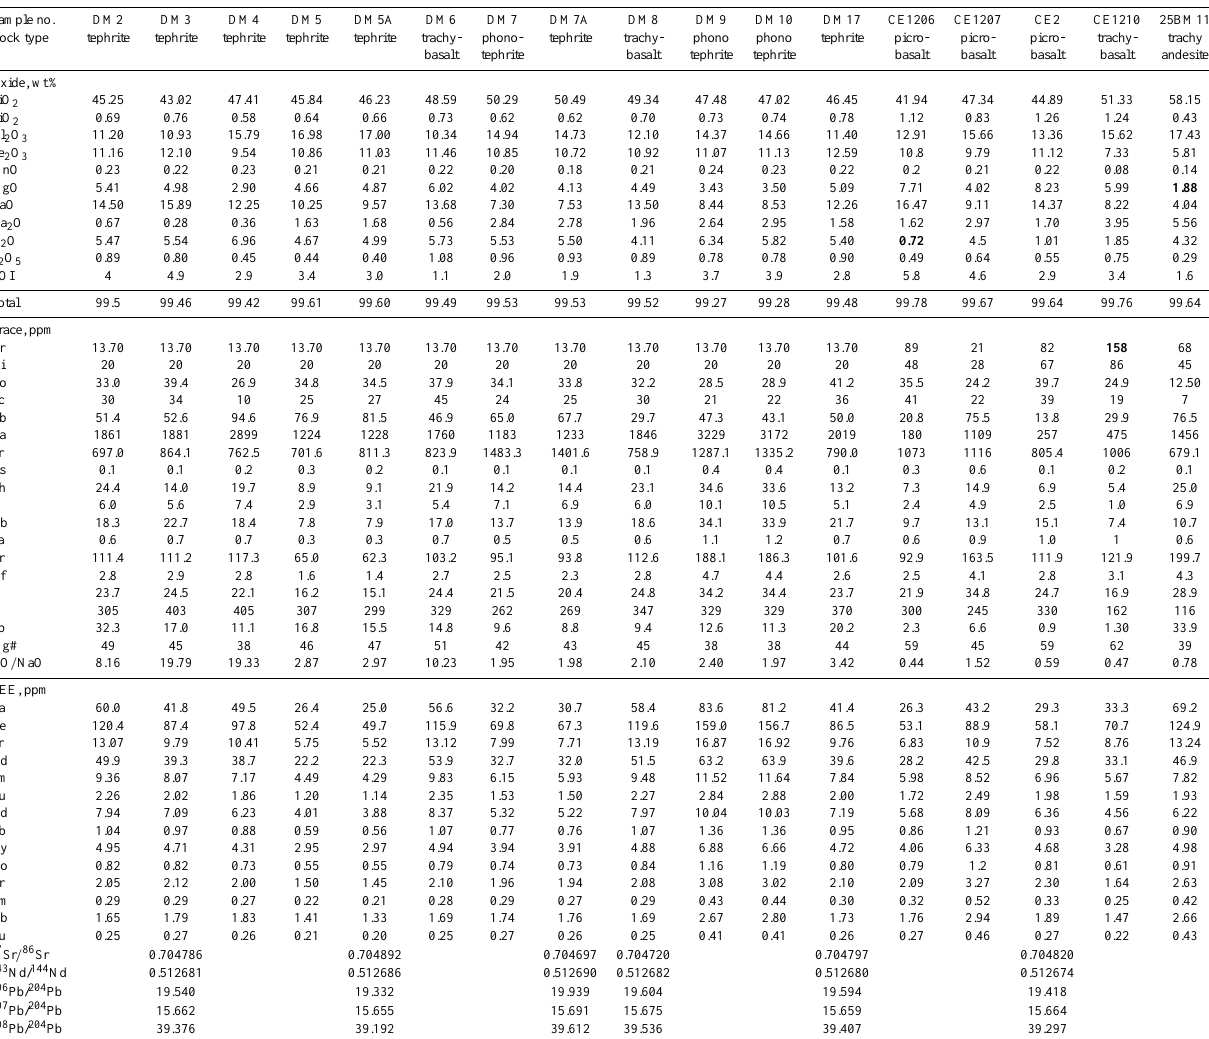
Table 9. Major, trace element and REE data for a select group of lamprophyric dike rocks from the Ankara Mélange.